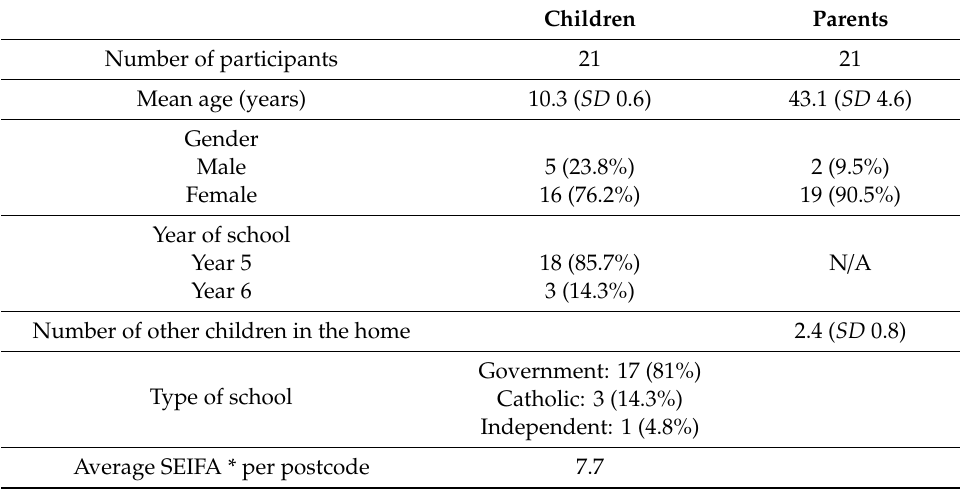
Table 2. Descriptive